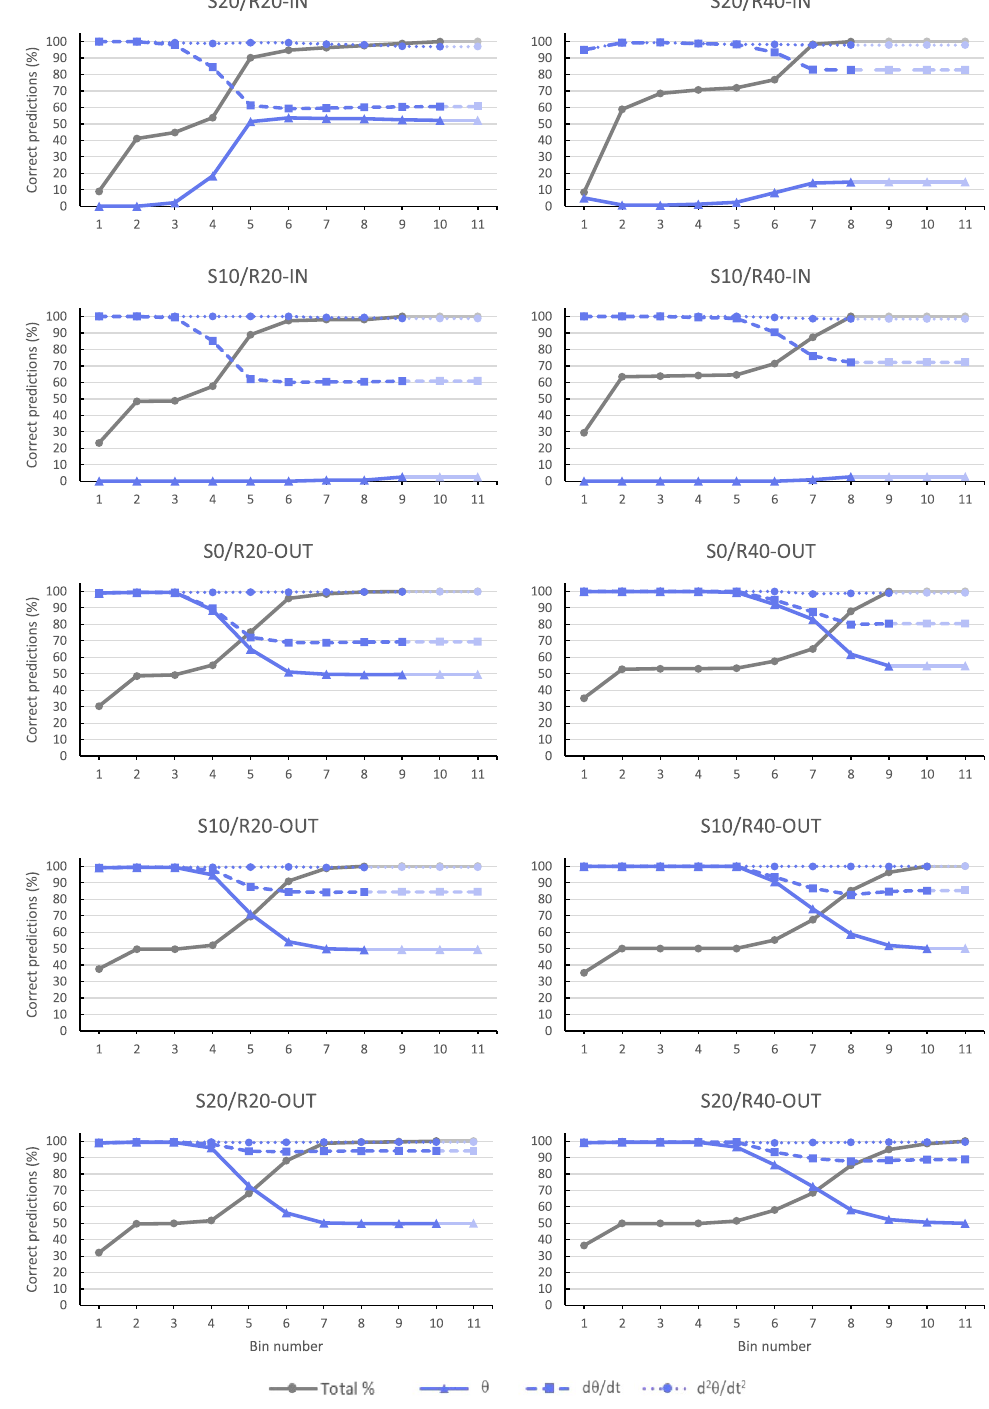
Figure 4. Cumulative percentage correct predictions over 0.5 s time bins of upcoming steering direction signalled a visuomotor delay Δt = 0.1 s earlier by θ (full blue line), dθ/dt (dashed blue line), or d 2 θ/dt 2 (dotted blue line) for each of the 10 experimental target trajectory conditions (see Table 1 for trajectory codes). The dark grey line presents the cumulative percentage over (binned) time of the total number of observed steering events. Attenuated colours mark (empty) time bins extending beyond the condition’s observed action duration. Qualitatively similar results were obtained for Δt = 0.2